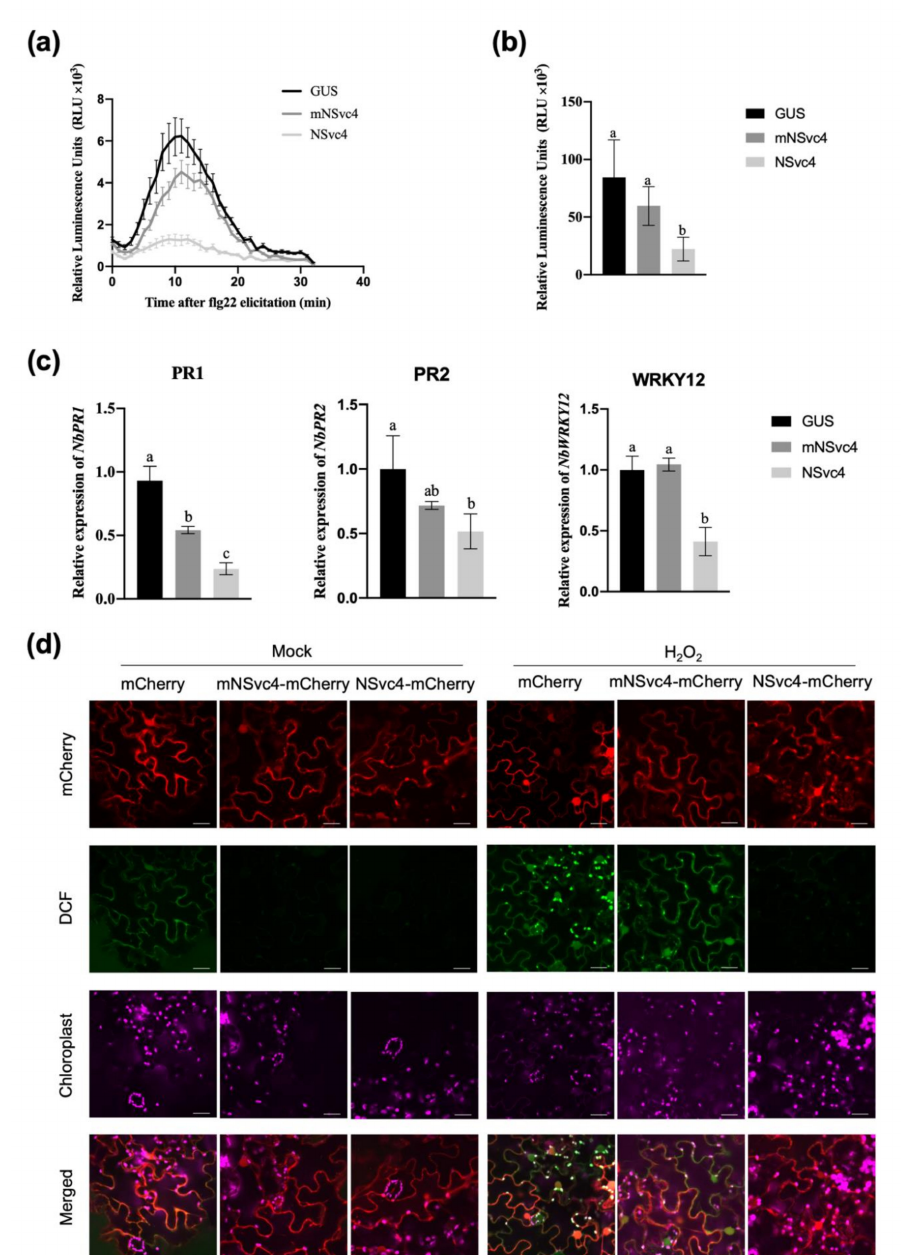
Figure 2. The localization of NSvc4 in chloroplasts inhibits host defense response. ( a , b ) ROS pro- duction as relative luminescence units (RLU) during 30 min in response to the elicitor flg22 in N. benthamiana leaves expressing GUS, mNSvc4, and NSvc4. Values represent the average of eight plants. Error bars represent SE. Different labels represent statistical significance ( p < 0.01) by one-way ANOVA and Tukey’s test. ( c ) The relative expression levels of NbPR1 , NbPR2 , and NbWRKY12 in N. benthamiana leaves transiently expressing GUS, mNSvc4, and NSvc4 after infiltration with flg22 were assayed by qRT-PCR, with the NbActin as a reference gene for normalization. The relative expression levels were normalized by setting the value of GUS control as 1.0 in each leaf ( n = 3 biological replicates). Different labels represent statistical significance ( p < 0.01) by one-way ANOVA and Tukey’s test. ( d ) N. benthamiana leaves infiltrated with agrobacterium expressing mCherry control, mNSvc4-mCherry, and NSvc4-mCherry were treated with ddH 2 O or 5-mM H 2 O 2 for 24 h, followed by the treatment of H 2 DCF-DA. DCF signals were observed under confocal microscope. Bar, 20 µ